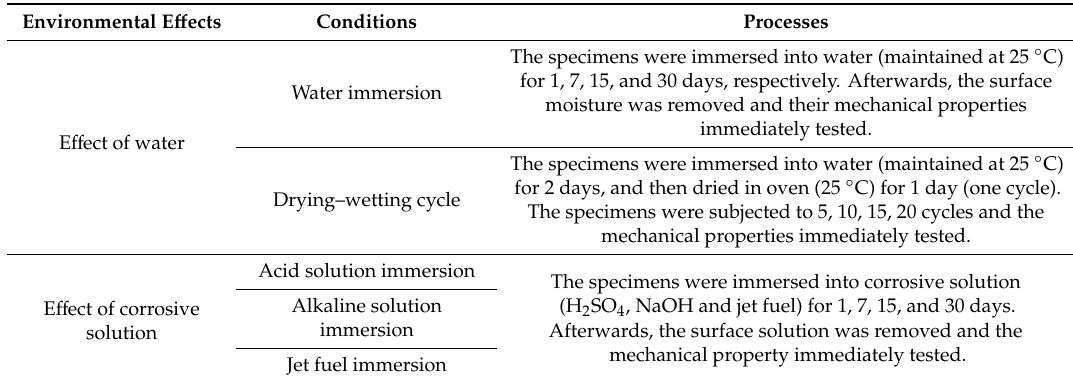
Table 3. Durability group test